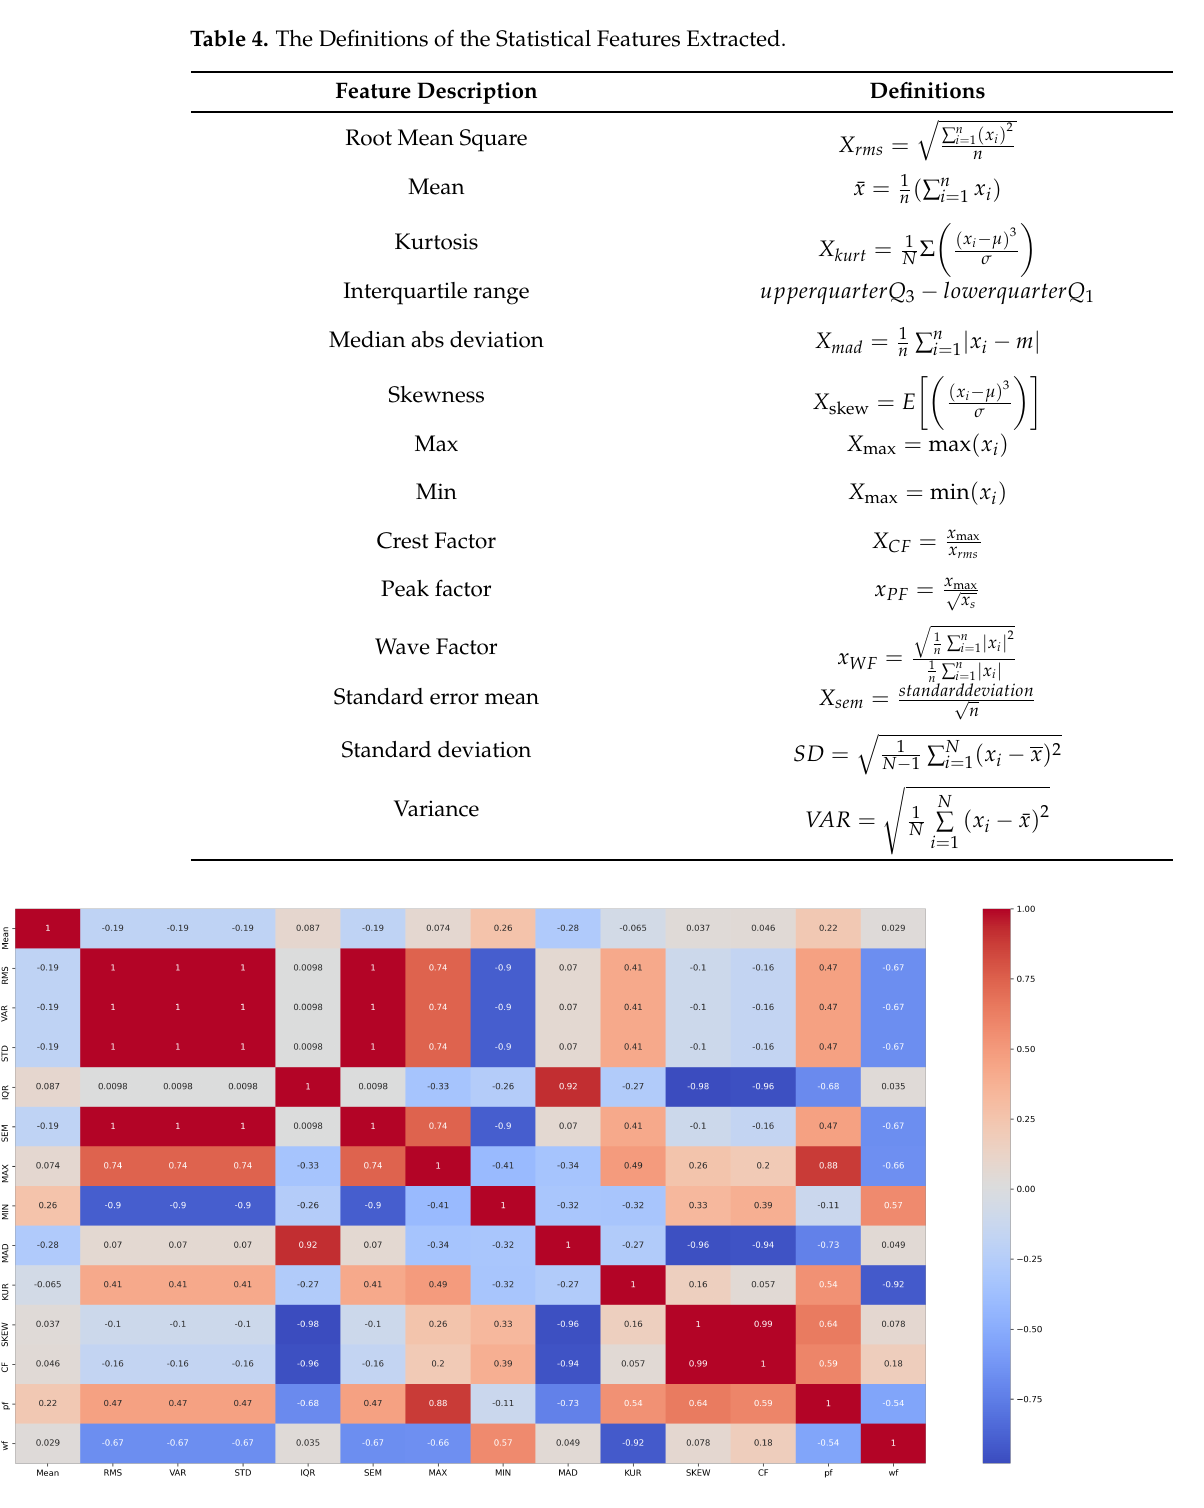
Figure 8. Feature extraction plot for the capacitance